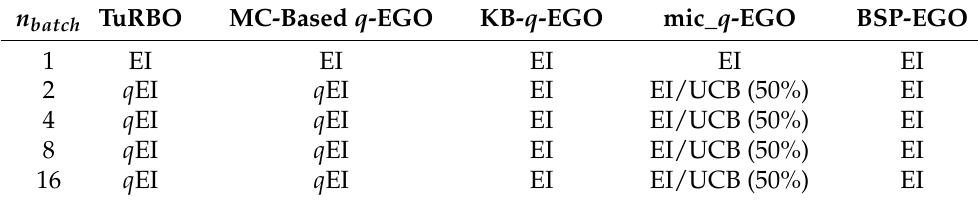
Table 3. Acquisition function according to the algorithms and batch